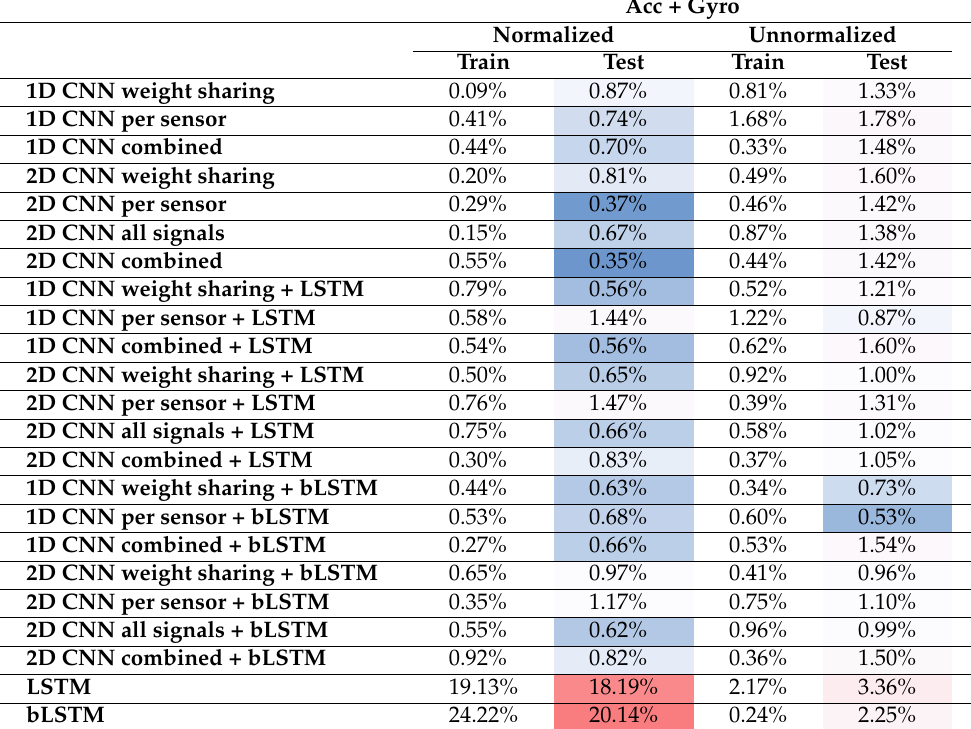
Table 4. Comparison of standard deviation of the prediction accuracies between the original unnor- malized models and the normalized ones. Five runs. A red-to-blue color code is used to facilitate the visualization of the values on the test dataset, where red is worse and blue is